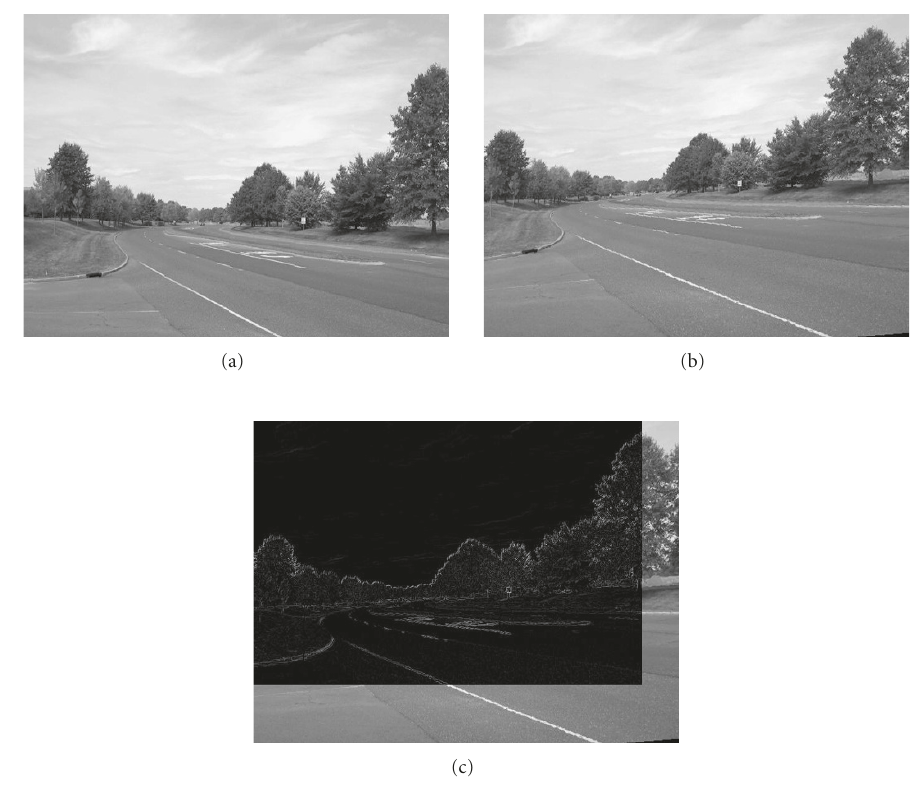
Figure 5: Two neighboring images and their warping di ff